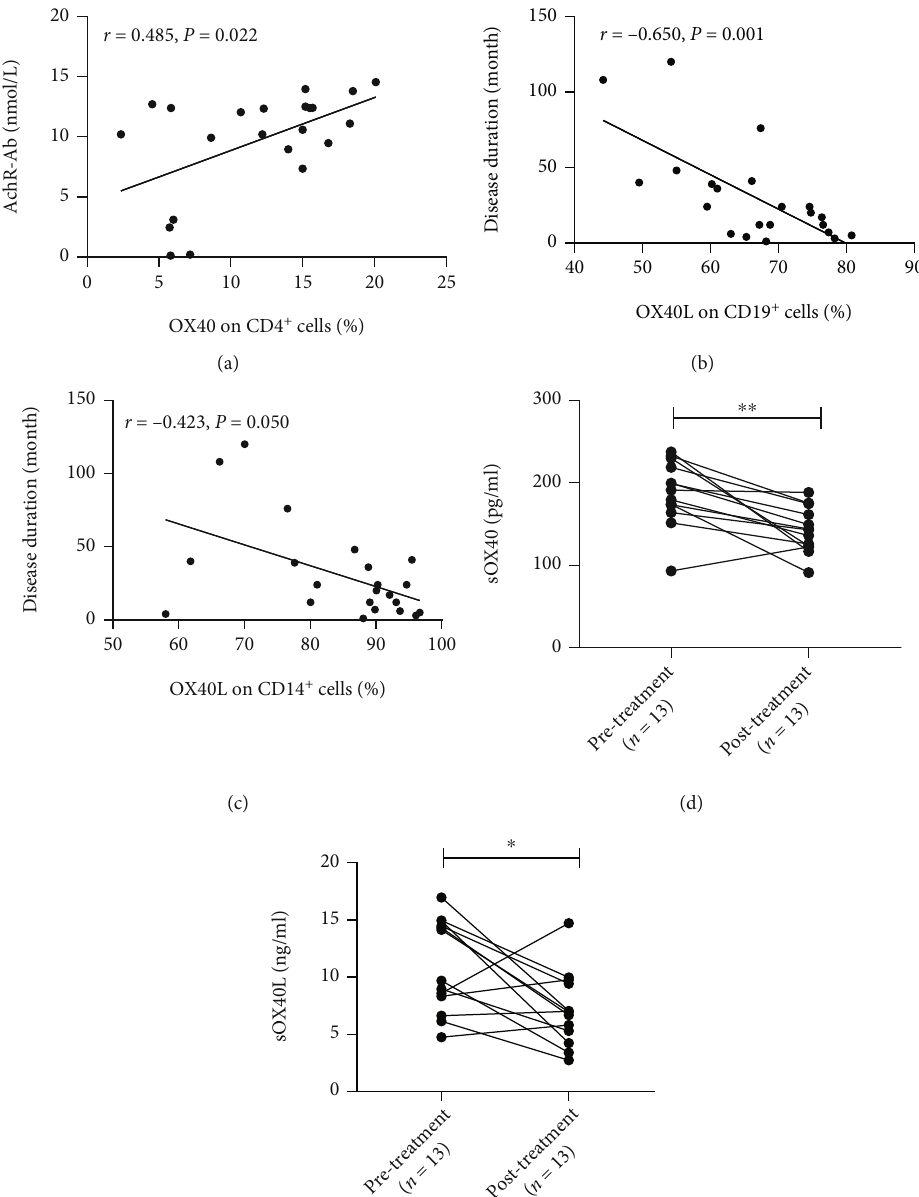
Figure 3: Clinical correlation diagram in patients with MG. (a) Linear correlations between the concentration of AchR-Ab and the expression of OX40 on CD4 + T cells in MG patients in relapse. (b) Linear correlations between the disease duration and the expression of OX40L on CD19 + T cells in MG patients in relapse. (c) Linear correlations between the disease duration and the expression of OX40L on CD14 + mononuclear cells in MG patients in relapse. (d) Comparison of sOX40 expression levels in plasma before and after immunosuppressive therapy in 13 MG patients with relapse. (e) Comparison of sOX40L expression levels in plasma before and after immunosuppressive therapy in 13 MG patients with